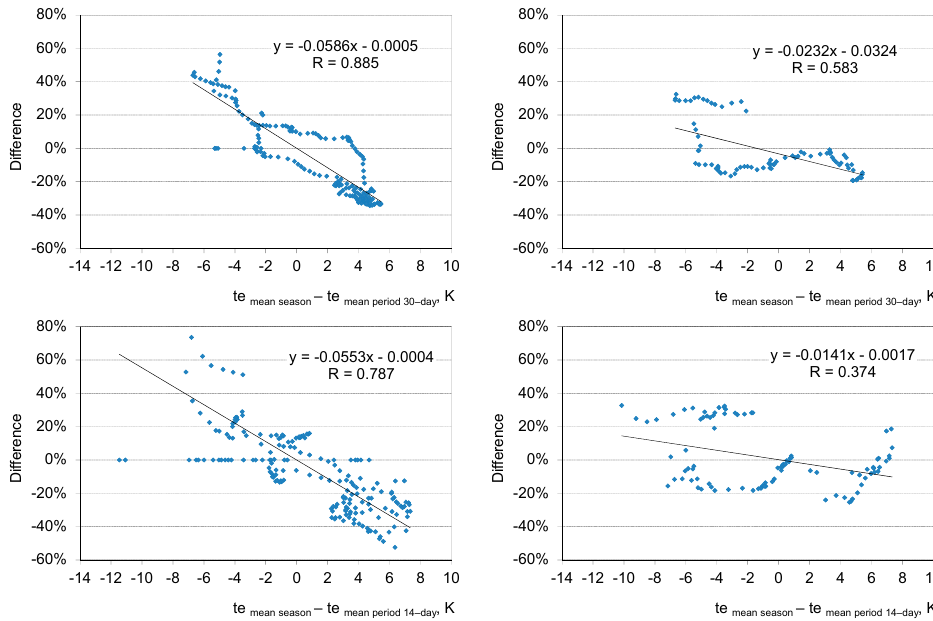
Figure 9. Correlation between the seasonal heat demand difference and external temperature difference (mean for the season and mean for each short period) for the better insulated residential building (on the left) and for the better insulated school building (on the right); only for periods with R ≥ 0.6.